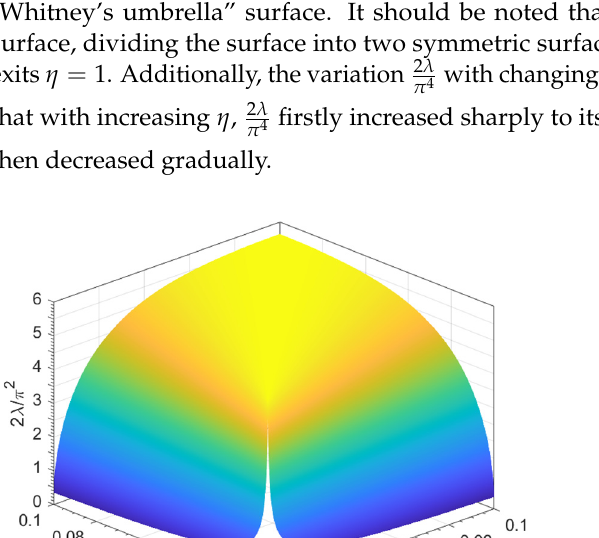
Figure 6. The variation of 2 λ